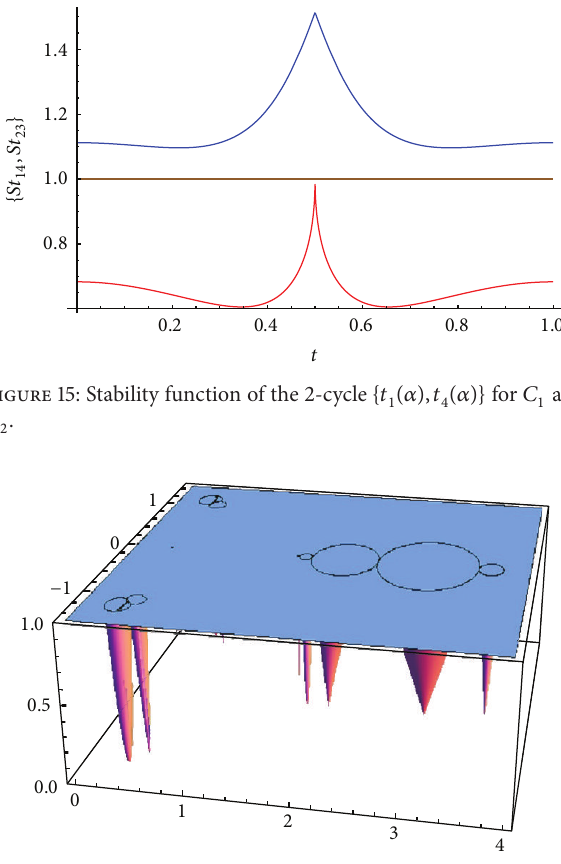
Figure 16: Stability functions of cycles of period